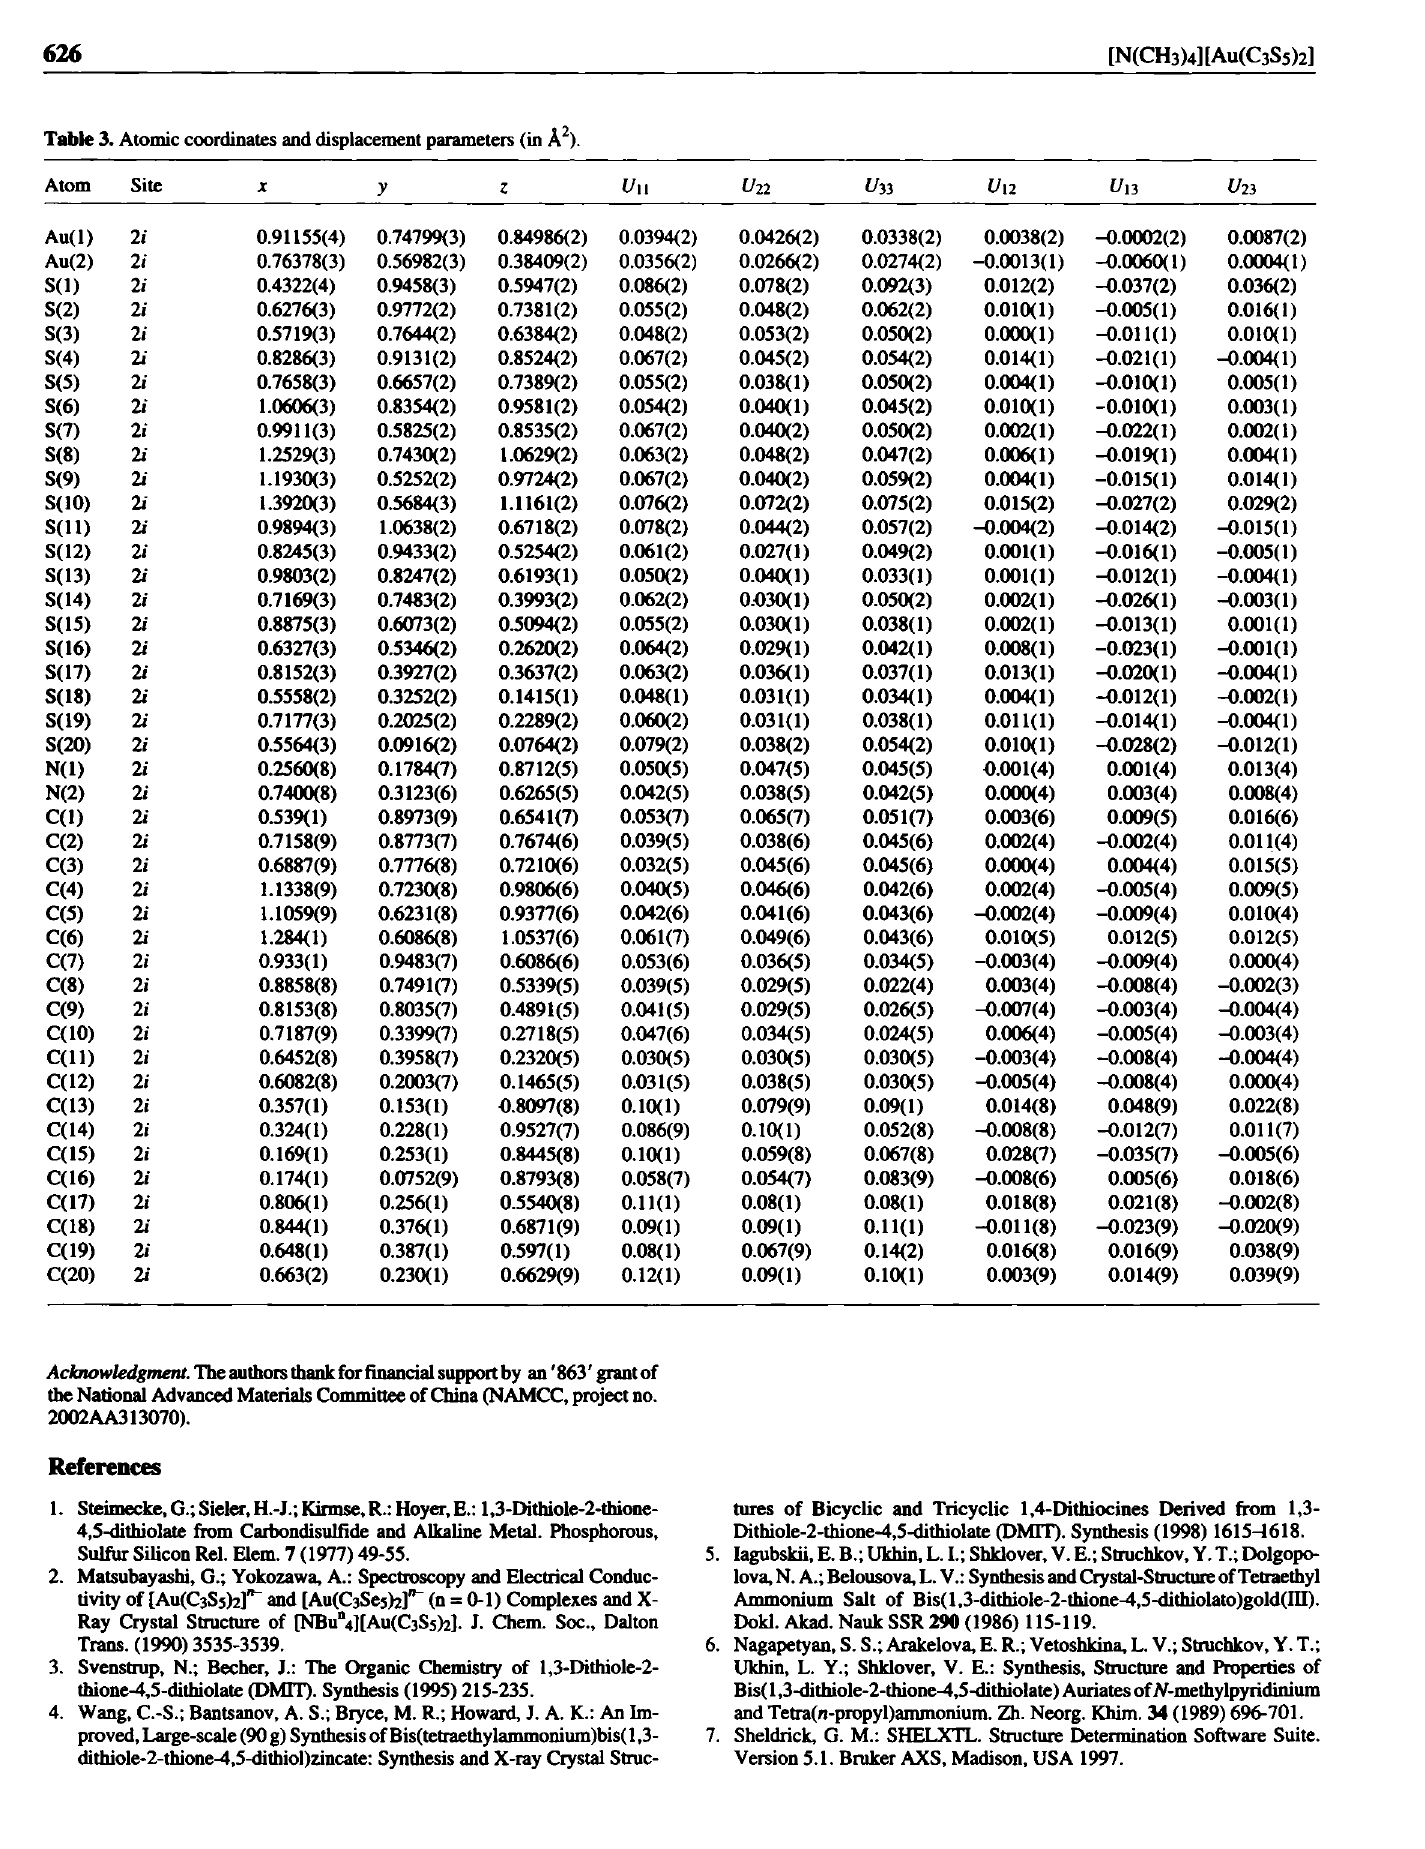
Table 3. Atomic coordinates and displacement parameters (in A 2